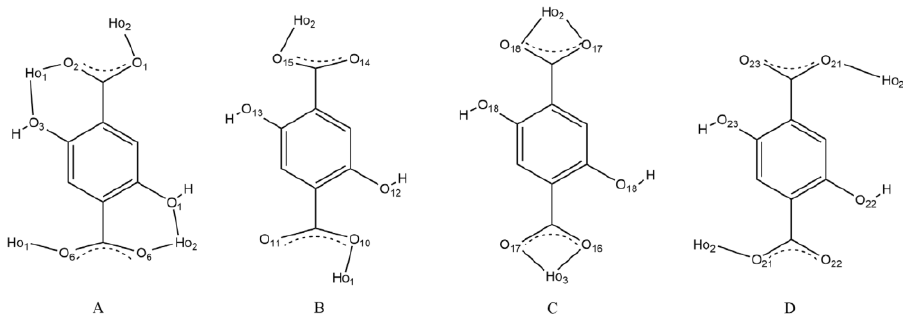
Scheme 2. Four connection manners of DHTA unit (the oxygen atom labels are consistent with the name given in cif). Figure 3. The 3D supramolecular meshy structure of complex 1 .